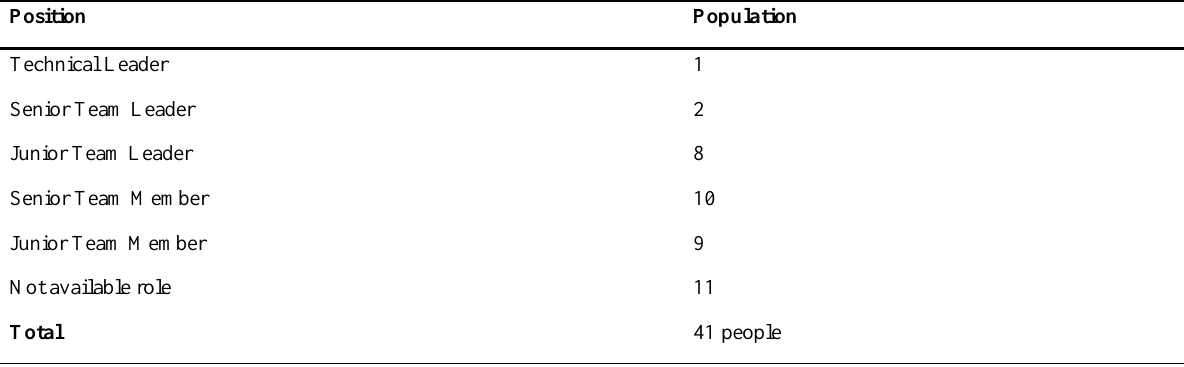
Table 1: Auditor at Audit Board of the Republic Indonesia the Provincial Representative of East Kalimantan